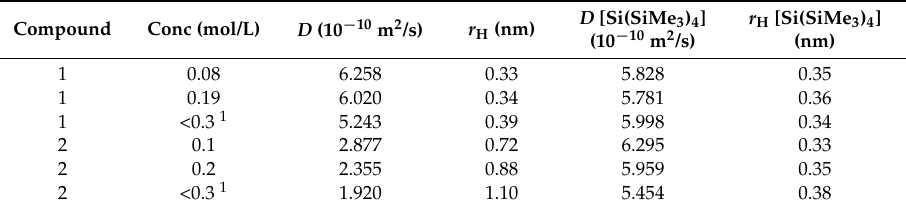
Table 3. Diffusion coefficients and calculated hydrodynamic radii for compounds 1 and 2 obtained from the 1 H DOSY NMR experiments in deuterated cyclohexane C 6 D 12 . Tetrakis(trimethylsilyl)silane